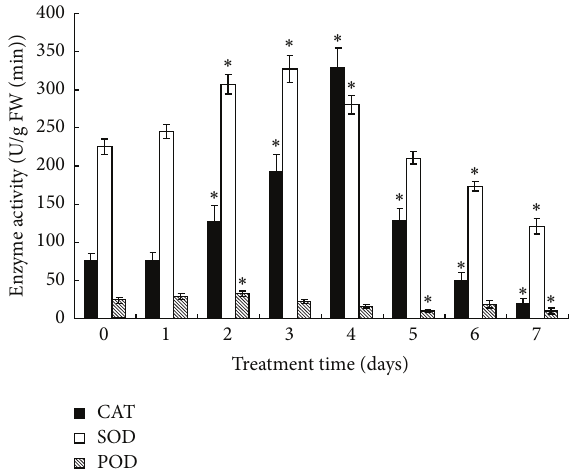
Figure 1: Activities of CAT, SOD, and POD in tissues of L. sinense under 500 mmol/L NaCl treatment. Values are means ± SD ( 𝑛 = 3 ). ∗ Significant difference between untreated (day 0) and NaCl-treated sample ( 𝑃 < 0.05